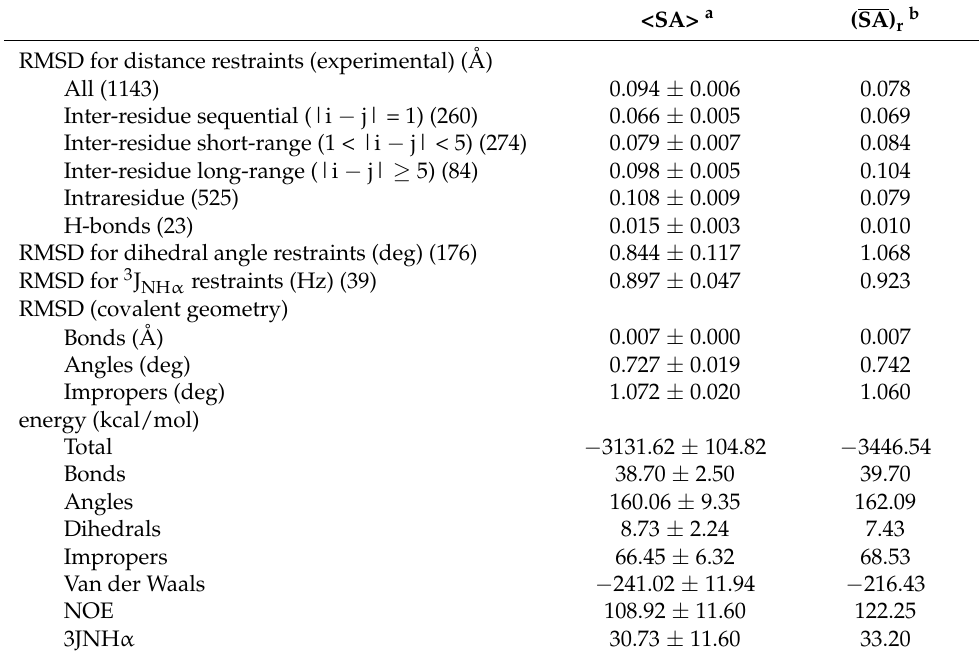
Table 1. Statistics for the DNAJA1-107 NMR Structure.